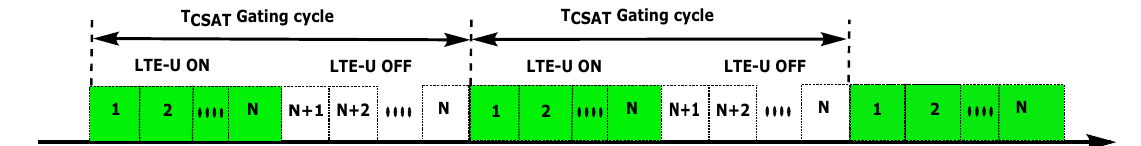
Figure 3. CSAT based channel access for LTE operation in the unlicensed